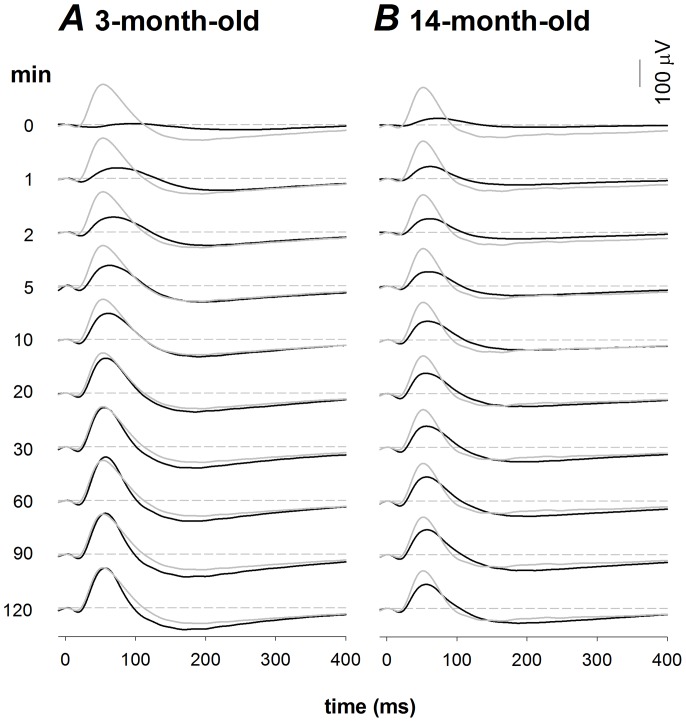
Representative photopic ERG waveforms of a 3-month-old (A) and 14-month-old animal (B) during recovery from acute IOP elevation.The black traces represent the average waveform at each time point whereas the grey waveforms indicate the pre-IOP baseline. The dashed lines indicate zero amplitude for reference.